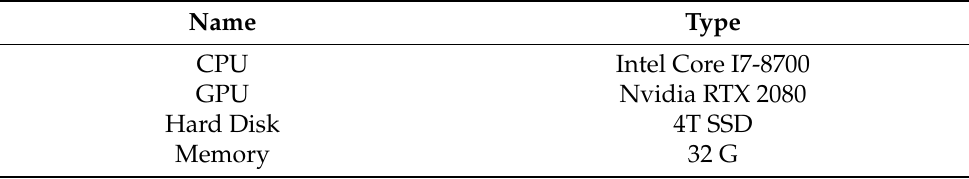
Table 1. Experimental Hardware